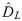
EU-emails: Normalized temporal differences for the three spectral distances: Combinatorial Laplacian D^L, normalized Laplacian D^L, and adjacency D^A.